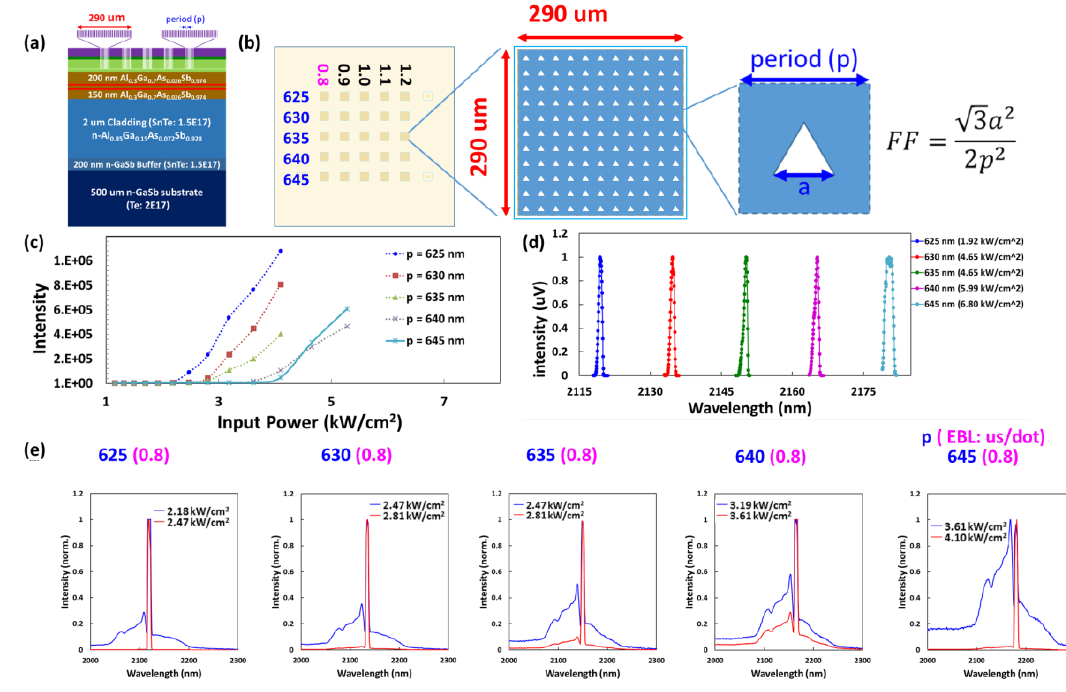
Figure 6. ( a ) Cross-section view and ( b ) top view of sample A; the figures are not drawn to scale (piece 2). ( c ) L-L curve, ( d ) normalized above-threshold lasing spectra, and ( e ) normalized emission spectra 234